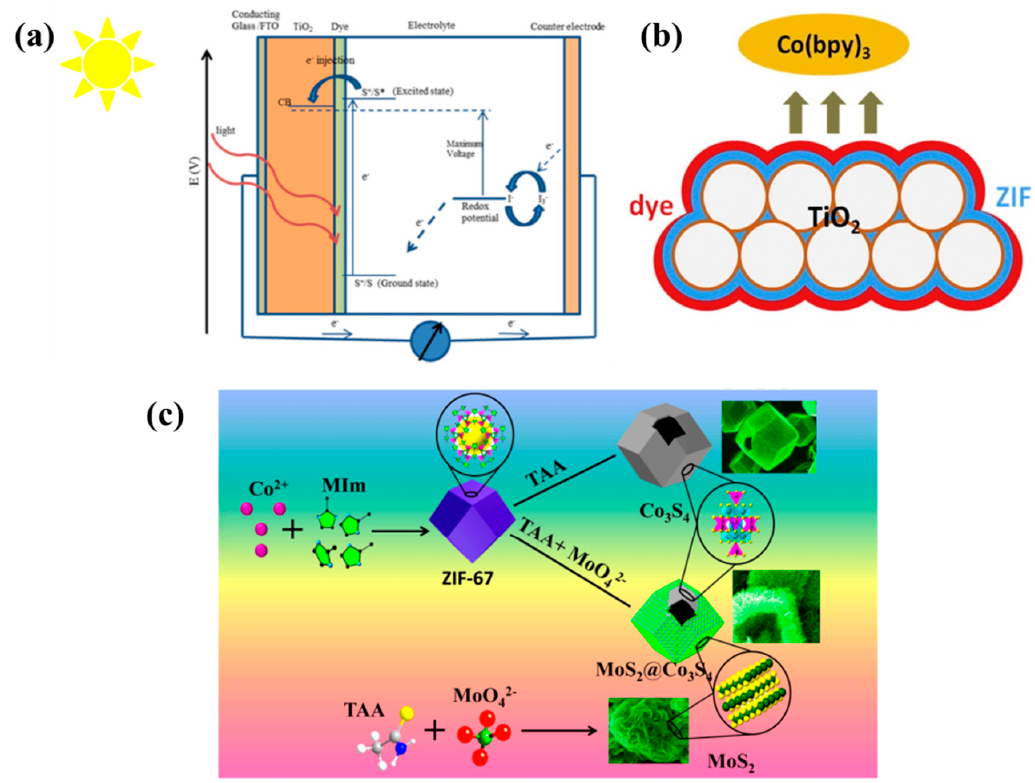
Figure 1. ( a ) A standard illustration of dye-sensitized solar cells (DSSC) [23]. ( b ) ZIFs as electron blocking layers for TiO 2 photoelectrode with tris(2,2 ′ -bipyridine) cobalt (II)/(III) as electrolyte [30]. ( c ) The preparation schema of MoS 2 @Co 3 S 4 composites-based metal-organic frameworks (MOF) material ZIF-67 [42].